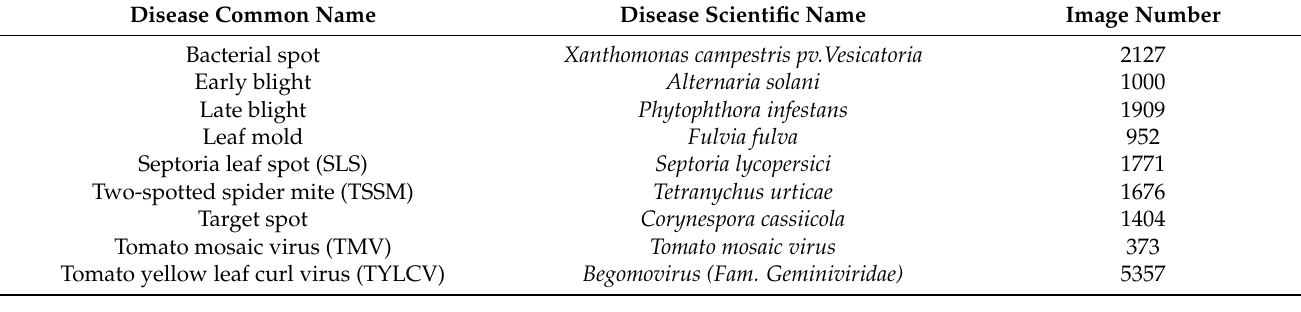
images horizontally. For tomato yellow leaf curl virus (TYLCV) diseases, we decreased the number of images from 5357 to 1985. The number distributions of the original dataset and the reorganized dataset can be seen in Figure 1. Table 1. The number of images of each tomato disease class in the PlantVillage dataset.